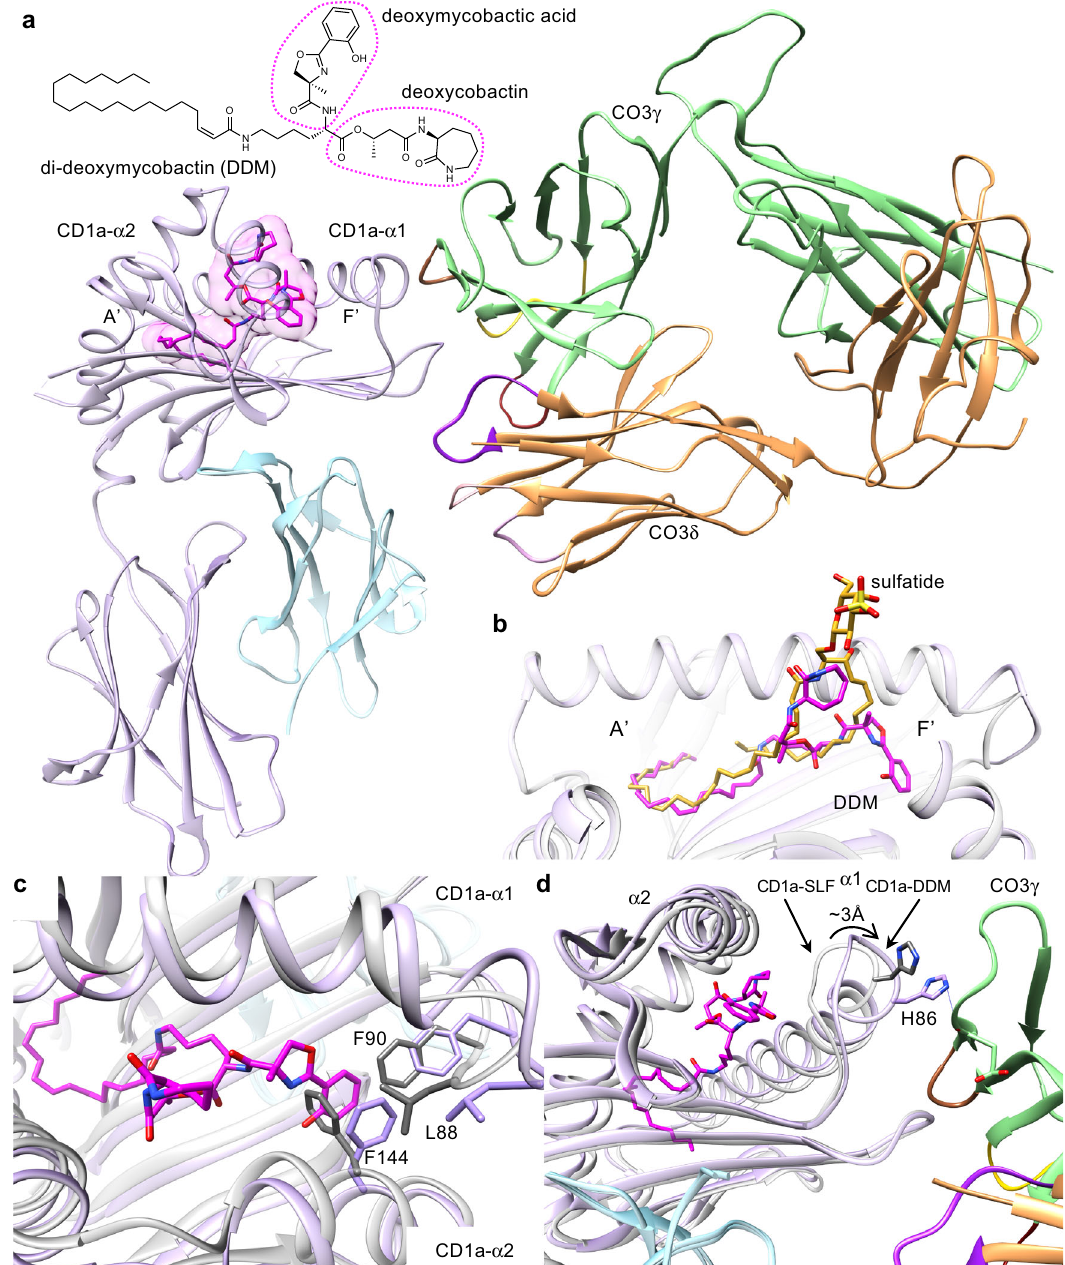
Fig. 5 Interaction between CO3 γδ TCR and CD1a carrying diverse lipid antigens. a Overview of CD1a-DDM-CO3 ternary structure shows the ligand orientation in the cleft of CD1a (lilac). DDM (magenta) fully occupies A ’ and F ’ pockets and does not signi fi cantly protrude through the F ’ portal of CD1a. b Relative position of the ligands in the cleft of CD1a bound to sulfatide (yellow) and DDM (magenta) in CD1a-CO3 ternary structures is shown. c Comparison of CD1a backbone in CO3-CD1a-sulfatide complex (light grey) and CO3-CD1a-DDM complex (lilac) shows that deoxymycobactic acid moiety of DDM (magenta) expands the F ’ pocket of CD1a by conformational changes of hydrophobic residues within the cleft of CD1a. d DDM-induced F ’ pocket expansion is associated with a 3 Å displacement of the CD1a- α 1 helix towards the FR γ region (green) of CO3 leading to a formation of an additional hydrogen bond (blue line) between CD1a His86 and the main chain of CO3 γ